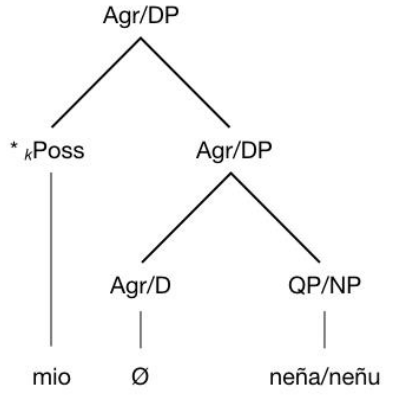
Figure 2. The possessive